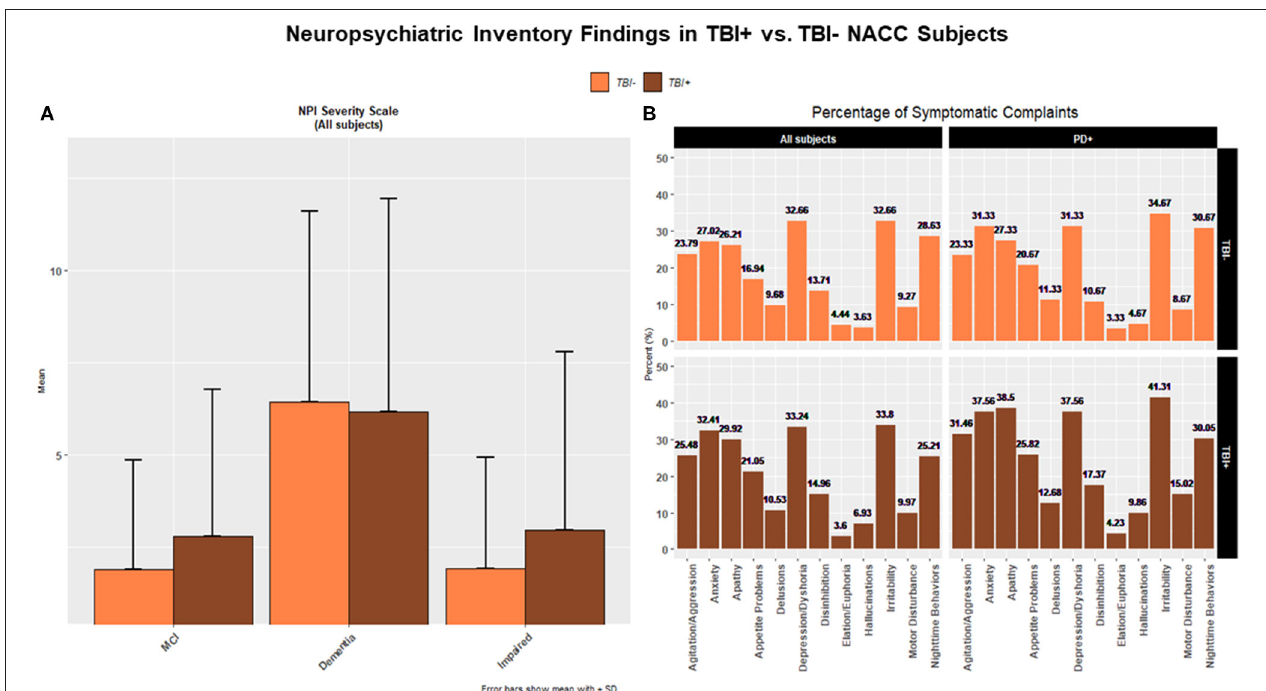
FIGURE 2 | (A) The figure shows bar plots of the mean scores for the Neuropsychiatric Inventory (NPI) for both TBI + (subjects with a previous history of TBI at the time of their first cognitive decline assessment) and TBI– (subjects without a previous history of TBI at the time of their first cognitive decline assessment) as clustered by their associated clinical diagnosis at the time of their first cognitive decline assessment. MCI, Mild cognitive impairment, Dementia [including Alzheimer’s disease (AD), Dementia with Lewy bodies (DLB), Progressive supranuclear palsy (PSP), Corticobasal degeneration (CBD), Frontotemporal Dementia (FTD), Vascular dementia (VaD), Traumatic brain Injury (TBI), normal pressure hydrocephalus (NPH), Depression, Cognitive decline due to systematic disease or medical illness], non-AD Impairment (Impaired). A trend for TBI + subjects with a diagnosis of MCI and Impaired to have a higher frequency of neuropsychiatric disorders and symptoms as mostly listed in the NPI was observed. (B) The histograms show percentages (%) of frequency for NPI-based neuropsychiatric disorders in TBI– and TBI + groups across all subjects (upper and lower left panels) and PD subjects (upper and lower right